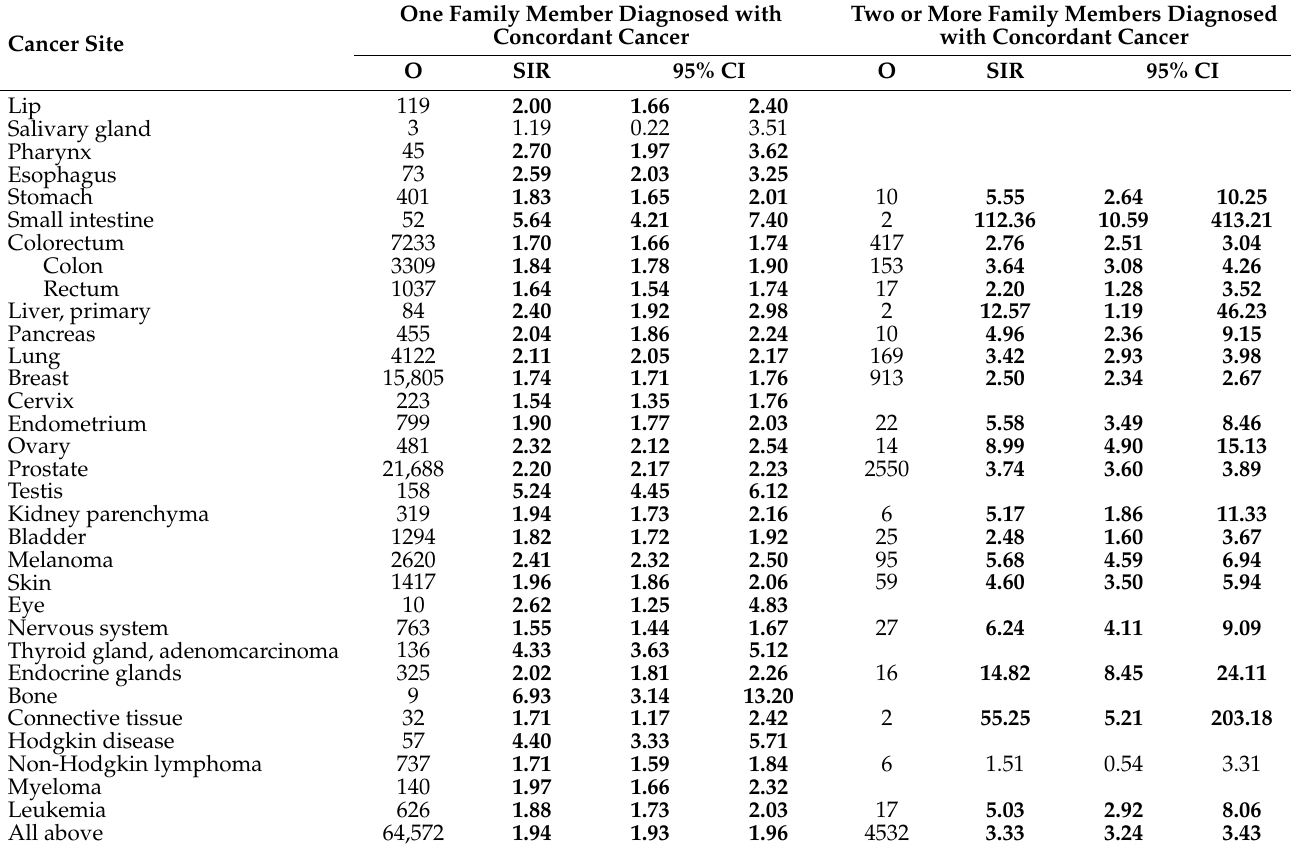
Two or More Family Members Diagnosed with Concordant Cancer